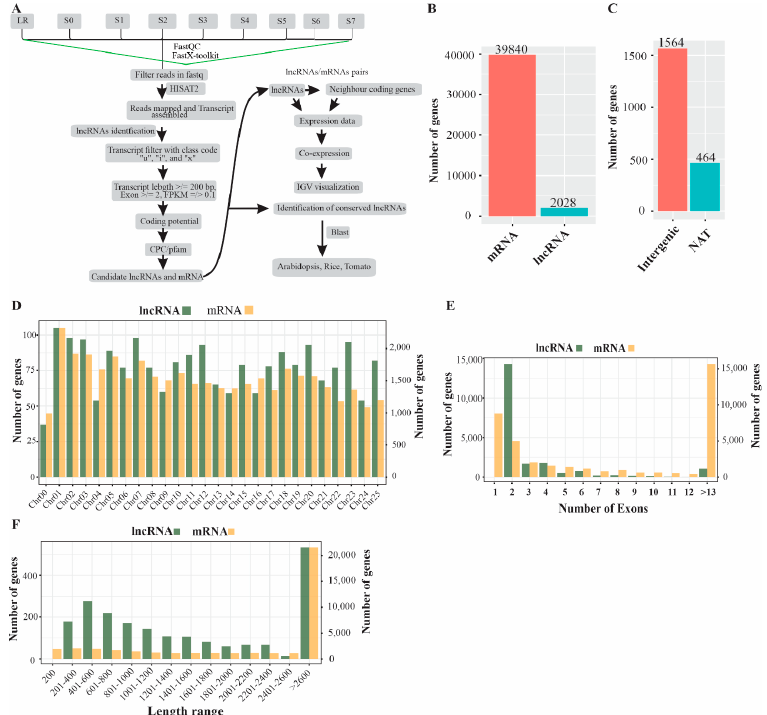
Figure 1. Identification pipeline and characterization of phosphorus-deficiency-responsive lncRNAs in the white lupin whole genome. ( A ) A simple pipeline to identify lncRNAs. ( B ) Number of coding (mRNA) and non-coding genes (lncRNA). ( C ) Types of lncRNA. ( D ) Chromosomal distribution of both mRNA and lncRNA. ( E ) Exon distribution of both mRNA and lncRNA. ( F ) Sequence length distribution of both mRNA and of lncRNA.